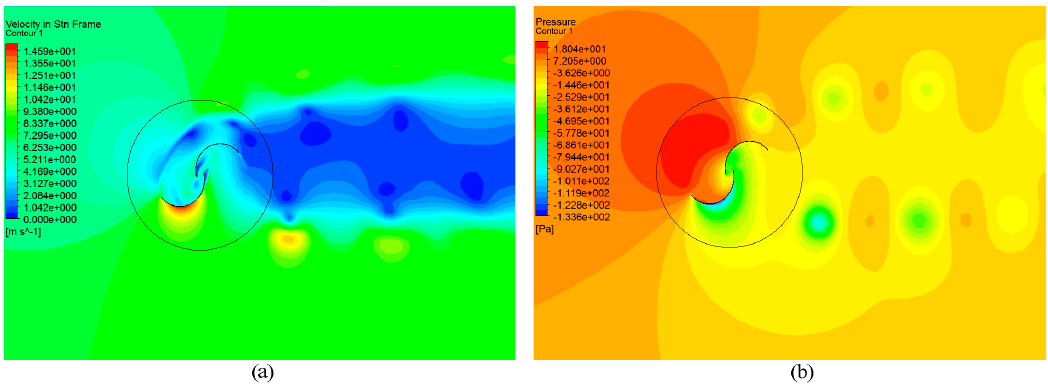
Figure 9. ( a ) Velocity distribution and ( b ) pressure distribution around a Savonius turbine. The instantaneous torque coefficient cyclically varies with the rotor angle, as shown in Figure 10a. Since the two blades are origin-symmetric, instantaneous torque coefficient is cycled twice in a rotation period (0°–360°) [8]. Averaged power coefficient increase with the TSR . The maximum of averaged power coefficient appears at about TSR = 1.0. After a fixed value, averaged power coefficient decreases, as shown in Figure 10b.